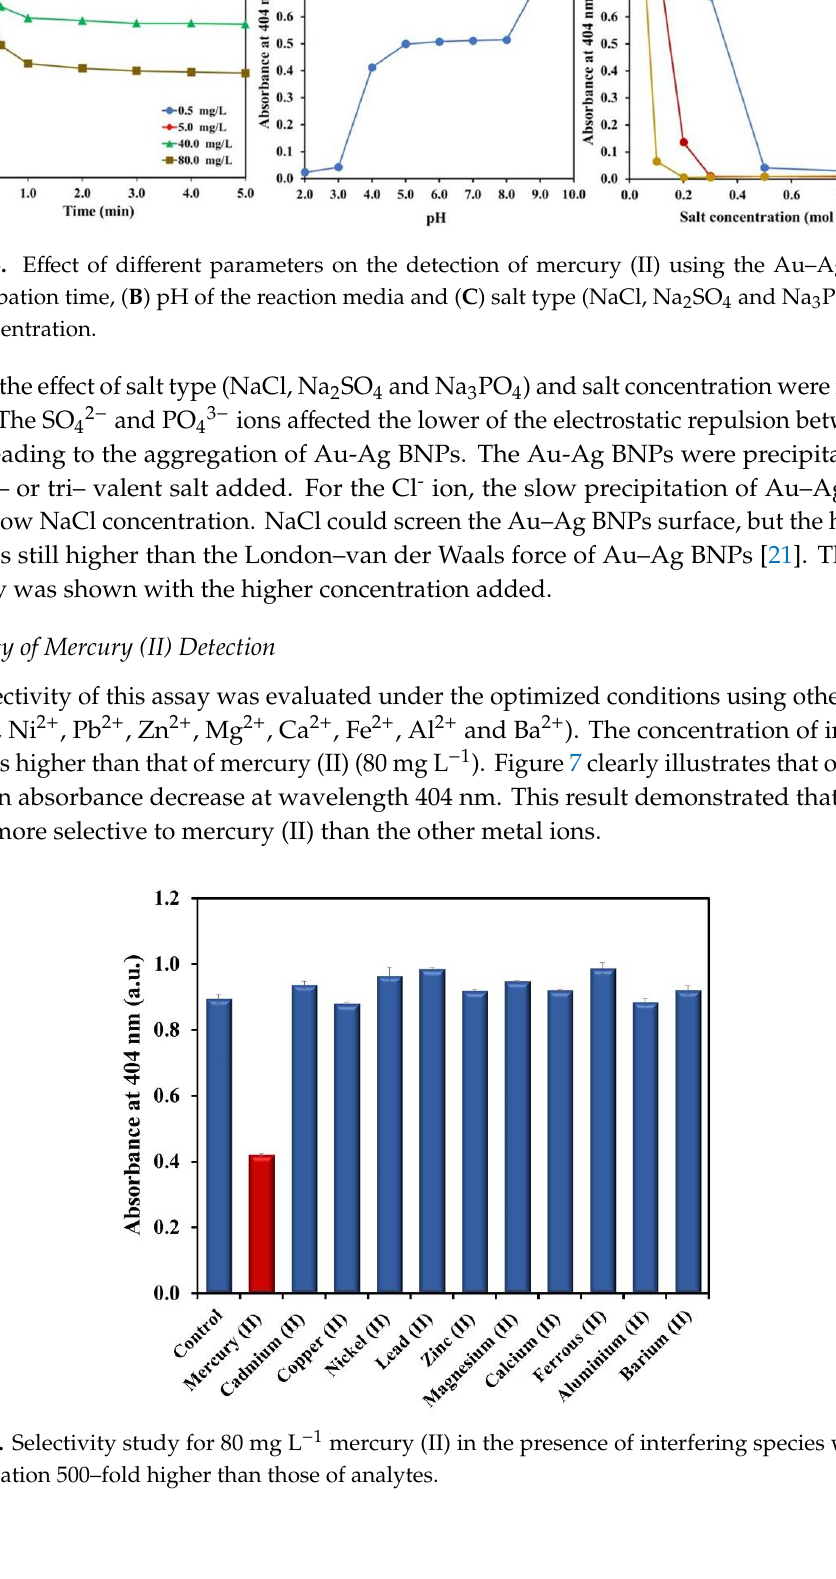
Table 1. Comparison of different methods for determination of mercury (II) . Colorimetric Probe LOD ( µM )